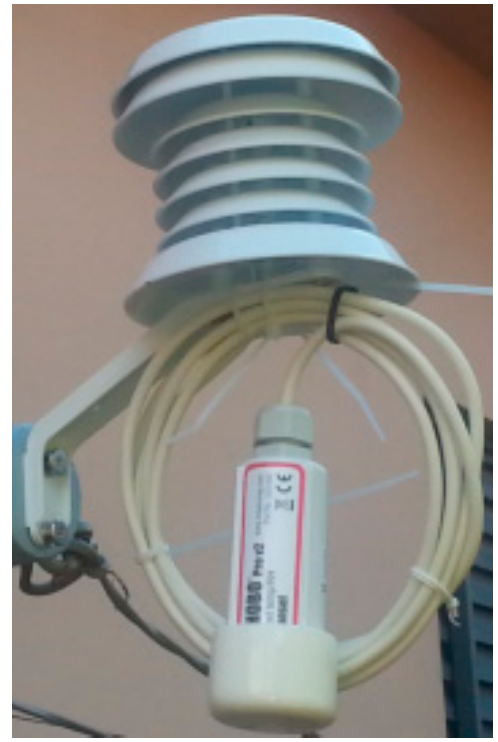
Figure 6. Meteorological shelter (type RS3–HOBO) with temperature and humidity recorder featuring external probe—U23-002 data logger–HOBO.